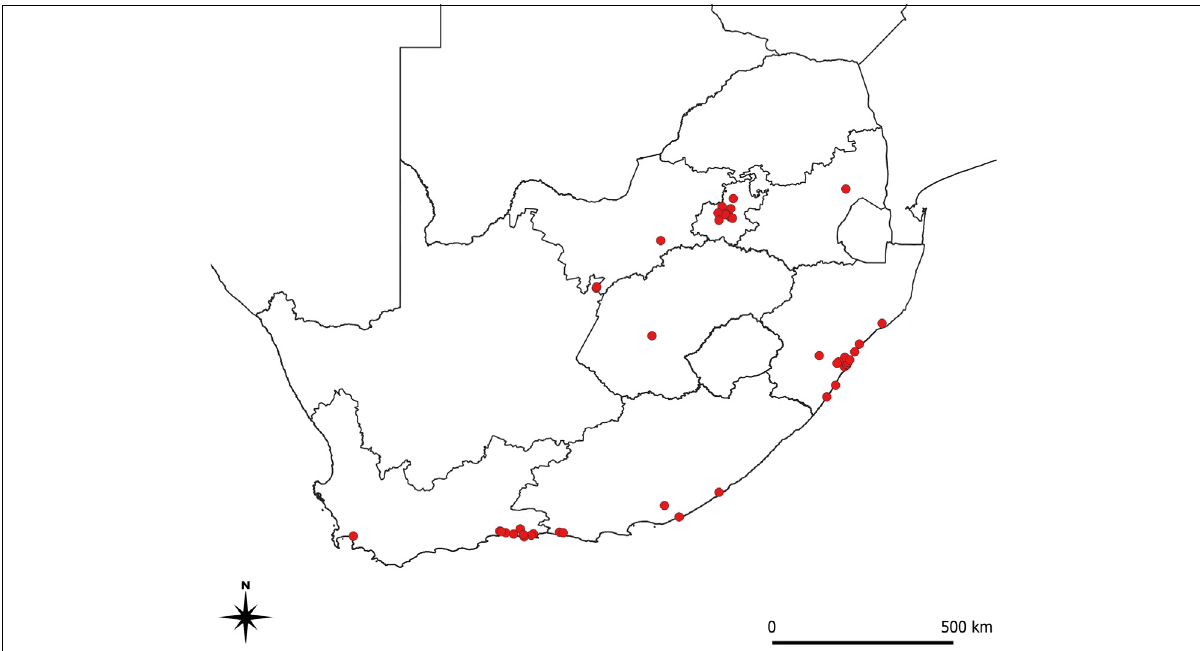
Figure 2: Distribution of the polyphagous shot hole borer beetle (PSHB; Euwallacea fornicatus ) in South Africa. Localities depicted are only those from which PSHB or its symbiotic fungus Fusarium euwallaceae were collected and their identities verified using DNA sequencing.